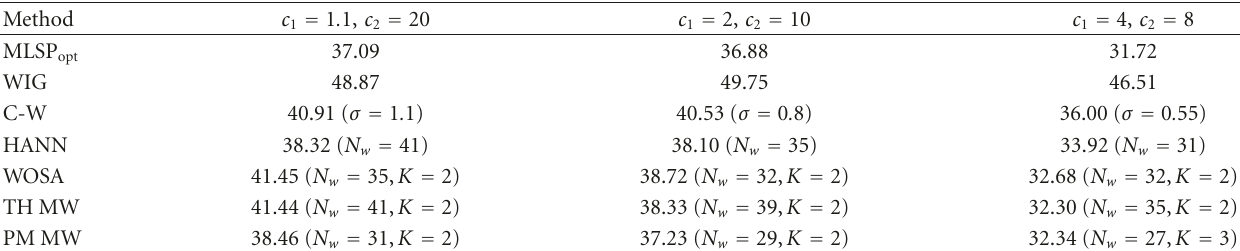
Figure 4: Optimal eigenvalues and eigenvectors corresponding to the ambiguity domain kernels in Figure 3 for N = 256 and F s = 7: (a) the 10 largest eigenvalues, (solid line = LSP, c = 1 . 1 and LSCP, c = 1 . 1, m = 2, d = − 2, dash-dotted line = LSP, c = 3, dotted line = MLSP, c 1 = 1 . 1, and c 2 = 20). Optimal eigenvectors: (b) c = 1 . 1; (c) c = 3; (d) c = 1 . 1, m = 2, d = − 2 (real-valued part only); (e) c 1 = 1 . 1 and c 2 = 20. Table 3: The mean square error of the MLSP-optimal multitapers and weights (MLSP opt ) compared to optimal choices of parameters for di ff erent methods evaluating the class of MLSPs in three cases: c 1 = 1 . 1, c 2 = 20; c 1 = 2, c 2 = 10; c 1 = 4, c 2 =